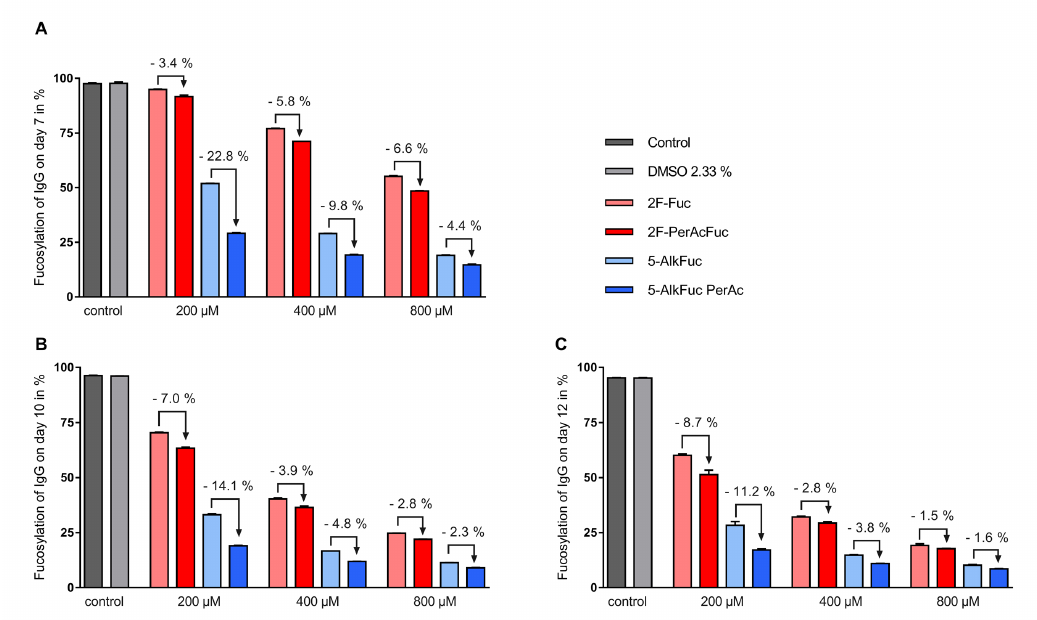
Figure 3. IgG fucosylation using two fucose analogues and the respective acetylated compounds. Feed was adjusted to 2.33% Dimethyl sulfoxide (DMSO) (except for the control) and added on day 3 (3%; v / v ), day 5, 7 and 10 (6%; v / v ). Fucosylation analysis on ( A ) day 7, ( B ) day 10 and ( C ) day 12 was obtained by UPLC-MS. Data are expressed as mean values ± SEM of two biological replicates. Statistical analysis was performed with all tested concentrations with and without peracetylation including data of additional experiments using various concentrations (data not shown). The data indicates a significant reduction of the IgG fucosylation compared to the control with a p -value < 0.0001 ( n = 19) for 5-AlkFuc analogues and a p -value of 0.0050 ( n = 19) for 2F-Fuc